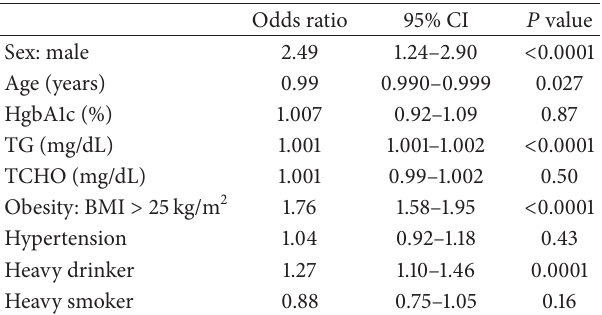
Table 5: Predictors for patients suffering from both reflux esophagi- tis and hiatal hernia.